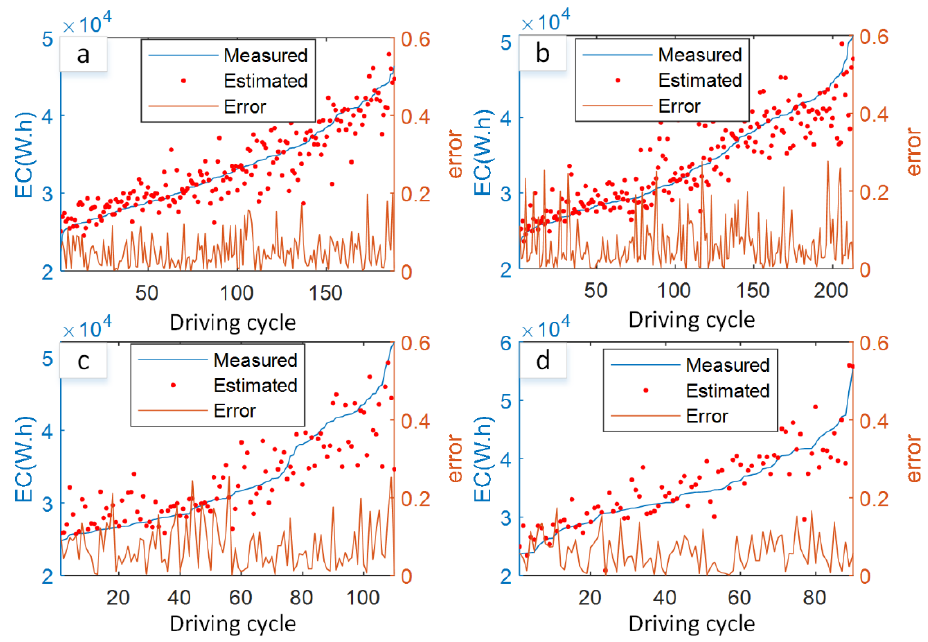
Figure 7. Energy consumption estimation results with the fusion model. ( a – d ) Bus 1 to Bus